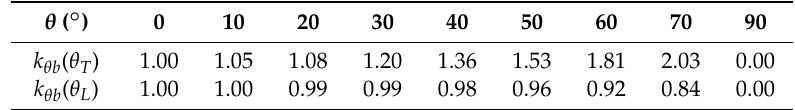
Table 3. Incident angle modifier [35].